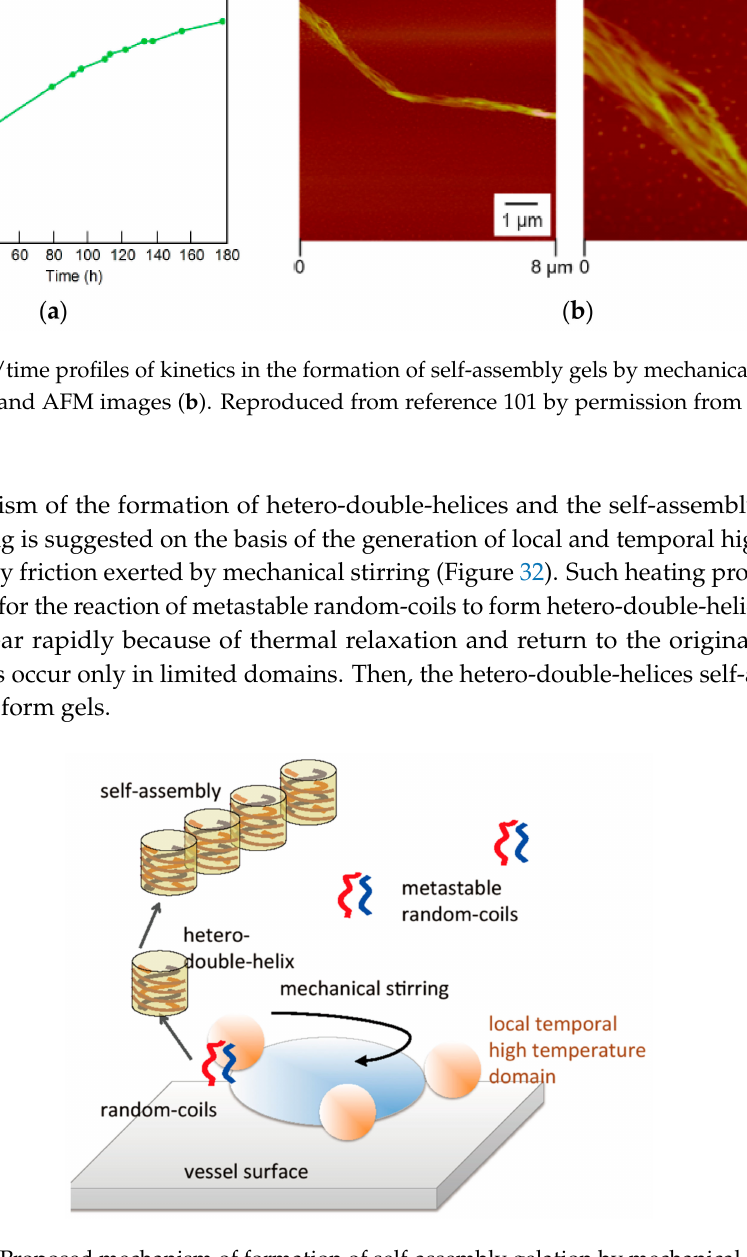
Figure 32. Proposed mechanism of formation of self-assembly gelation by mechanical